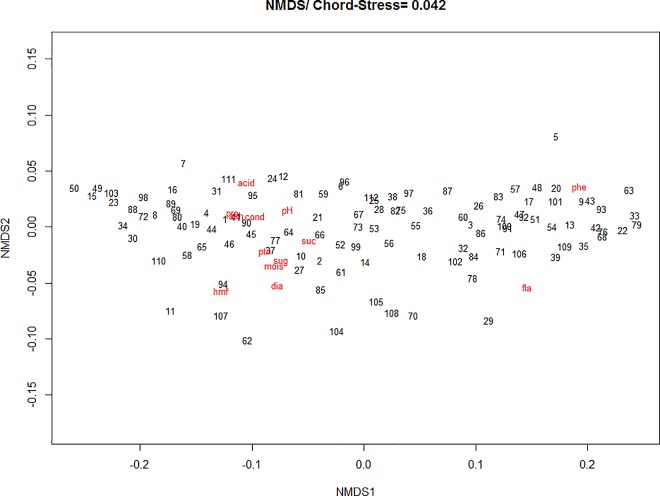
NMDS biplot of a chord distance matrix of the physicochemical data in honey (stress = 0.04).Sites: Mogadouro (1–10); Mirandela (11–20); Chaves (21–30); Castelo-Branco (31–40); Fafe (41–50); Lousã (51–60); Santarém (61–70); Odemira (71–80); Monchique (81–90); Montemor-o-Novo (91–100) and Amieira (101–112).